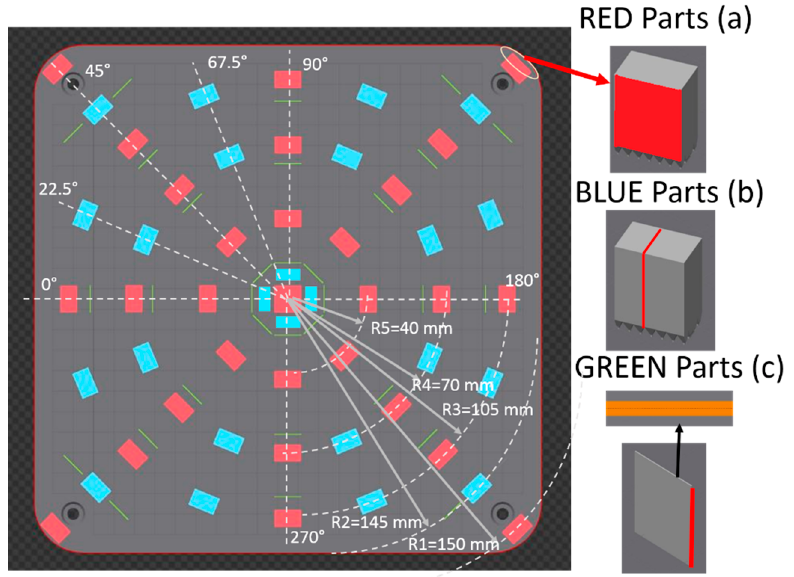
Figure 3. Design of the second platform: ( a ) parts for the roughness measurement; ( b ) parts for the microstructure analysis; ( c ) parts for measuring the thickness of thin walls.